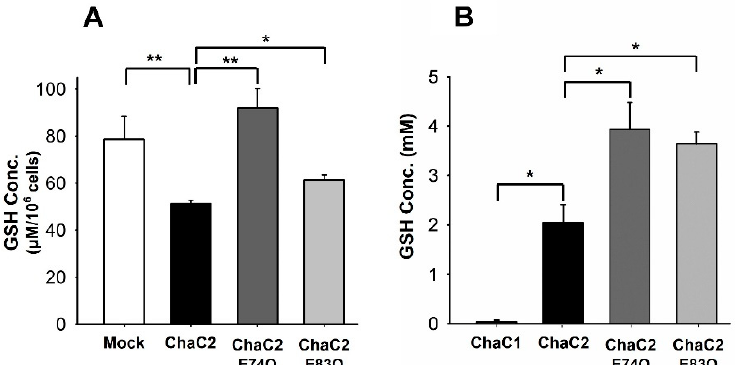
Figure 6. GSH level reduction in cells and in vitro by ChaC2. ( A ) The GSH levels in HEK293 cell lines transfected with Mock, ChaC2, ChaC2 E74Q, and ChaC2 E83Q-containing pEGFP-C3 plasmids were measured. ( B ) Briefly, 5 mM of GSH was incubated with ChaC1, ChaC2, ChaC2 E74Q, and ChaC2 E83Q and the levels of residual GSH were measured. Data represent the mean ± SEM (error bars) of three independent experiments. Asterisks indicate statistically significant differences; * p < 0.05; ** p < 0.01.